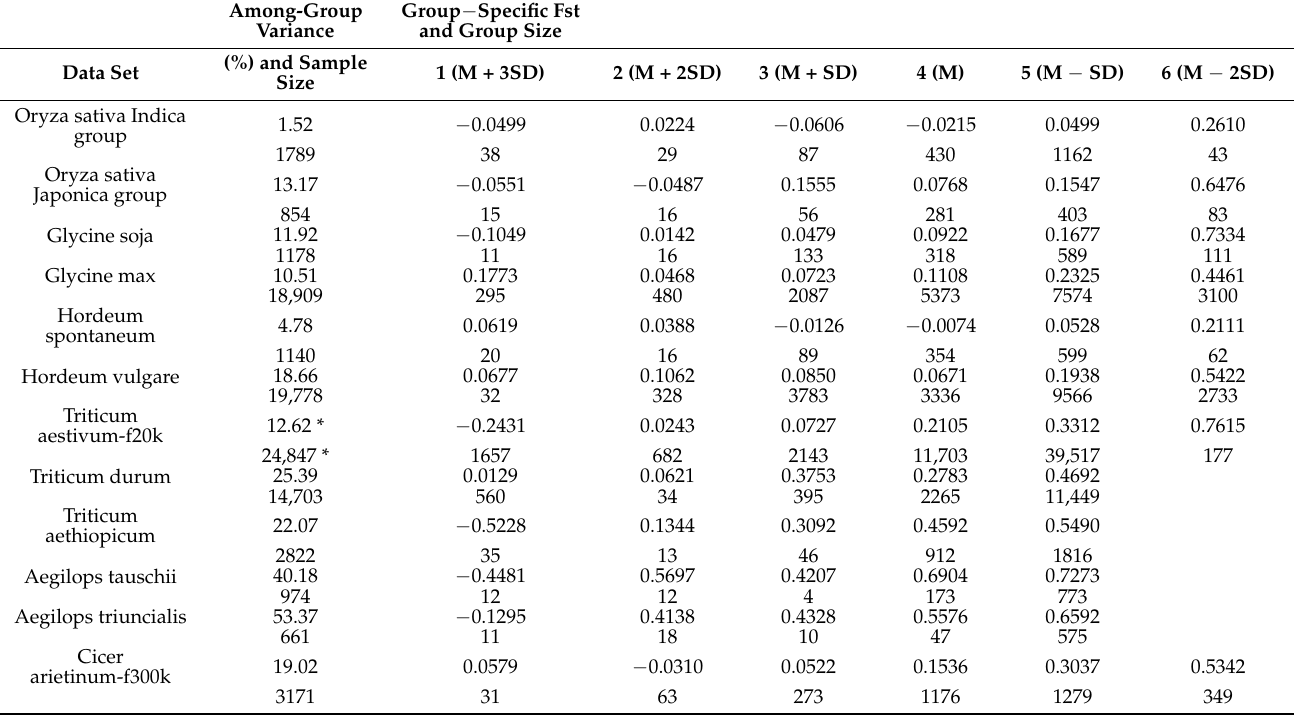
Table 1. APD grouping of the samples in 12 germplasm APD data sets and their diversity characteristics. Among-Group Group − Specific Fst Variance and Group